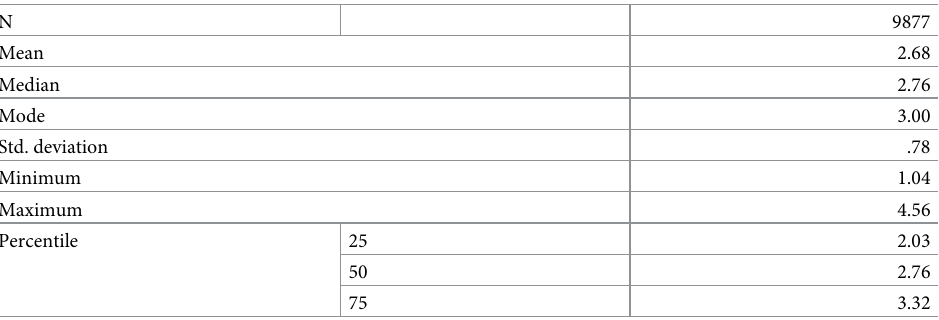
Table 1. Summary of concreteness